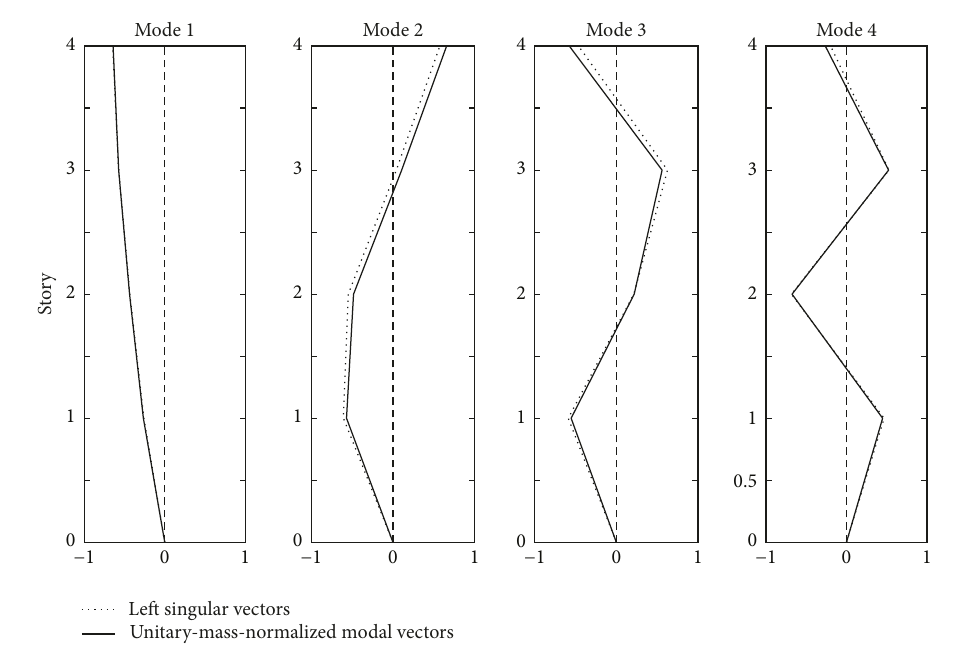
Figure 11: Comparison between identified left singular vectors and analytical modal shapes. In this representation the values are simply connected by continuous or dashed lines (resp., for identified and analytical values) in order to improve the graph